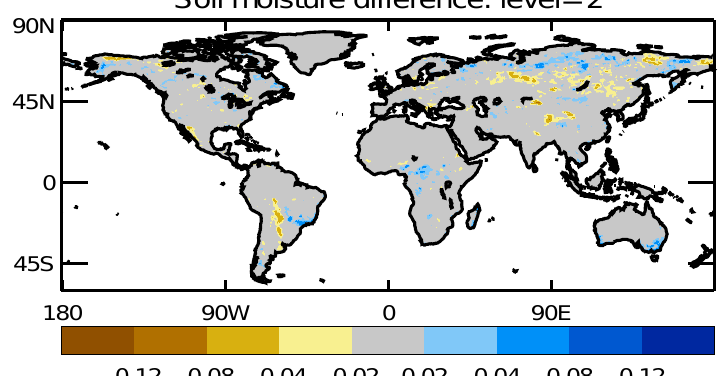
Fig. 7. Trial 1, Test minus Control differences in volumetric soil moisture (m 3 m − 3 ) for the July 2009 period. The top panel shows differences for the topmost UM soil level, the lower panel shows differences for UM soil level 2.